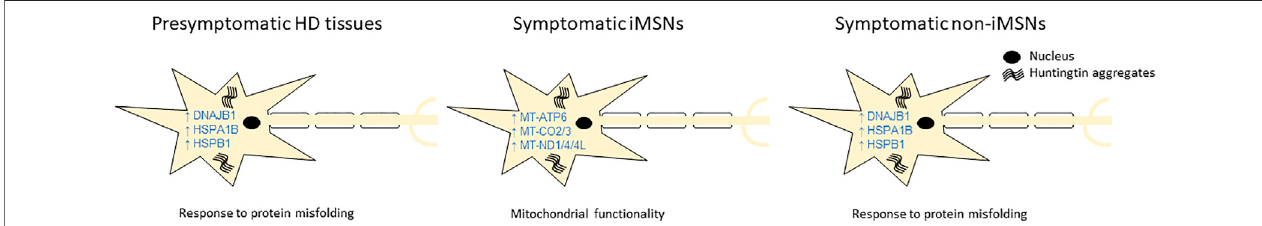
FIGURE 9 | Key differentially expressed genes (DEGs) and pathways potentially responsible for HD pathology. The diagram summarizes the key DEGs and pathwaysgeneratedfromdatasynthesis,whichmay explainthedifferentialvulnerability ofindirect pathwaymedium spinyneurons(iMSNs) compared toothercelltypes in